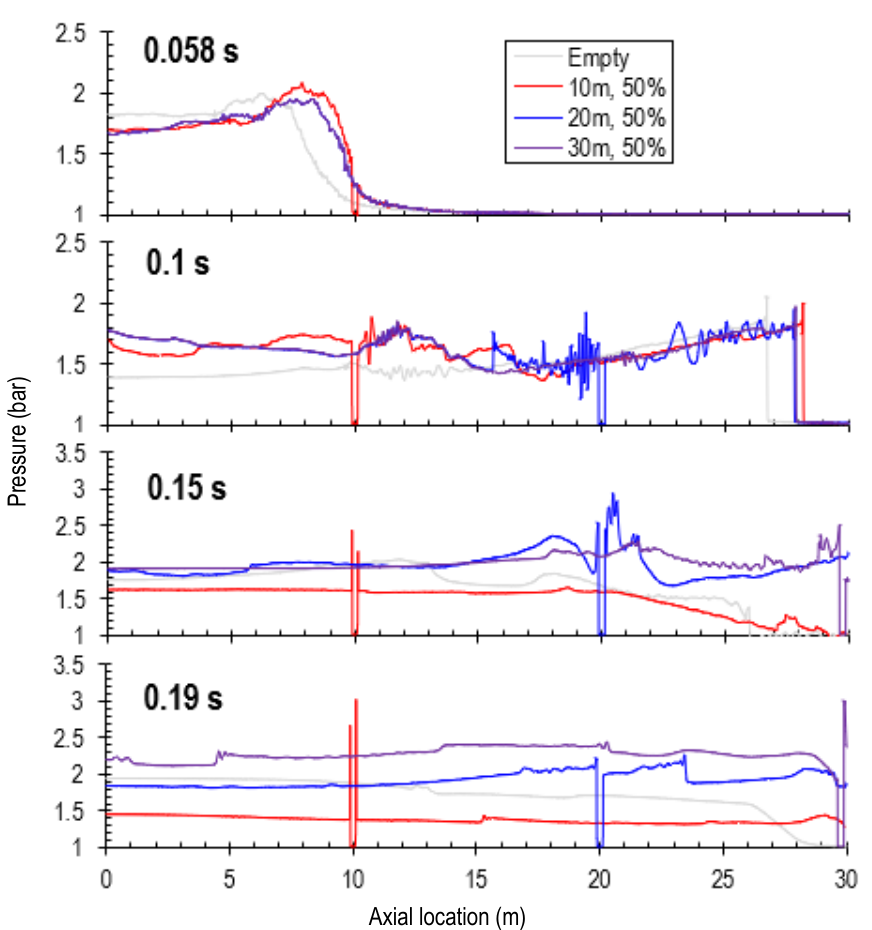
Figure 11. Evolution of pressure profiles along the tube centreline for different scenarios where a single obstruction is installed at different locations (at 10 m, 20 m and 30 m) with 50% inflation. The temperature profiles in the empty tube are also included for reference.